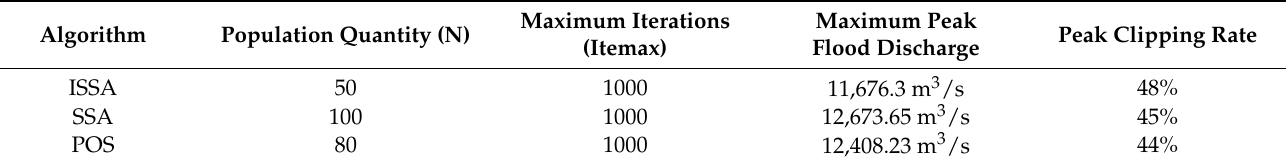
Table 3. Flood data of Huayuankou control point and initialization parameters of the